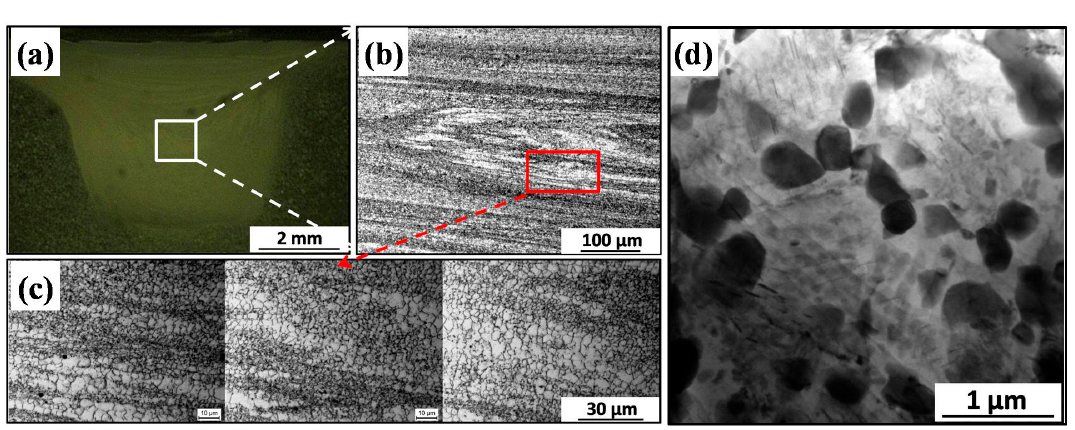
Figure 2. ( a ) Cross-section macrograph of the FSP specimen; ( b , c ) OM image of the center region in the SZ; and ( d ) TEM image showing second phase particles in SZ of FSP specimen.